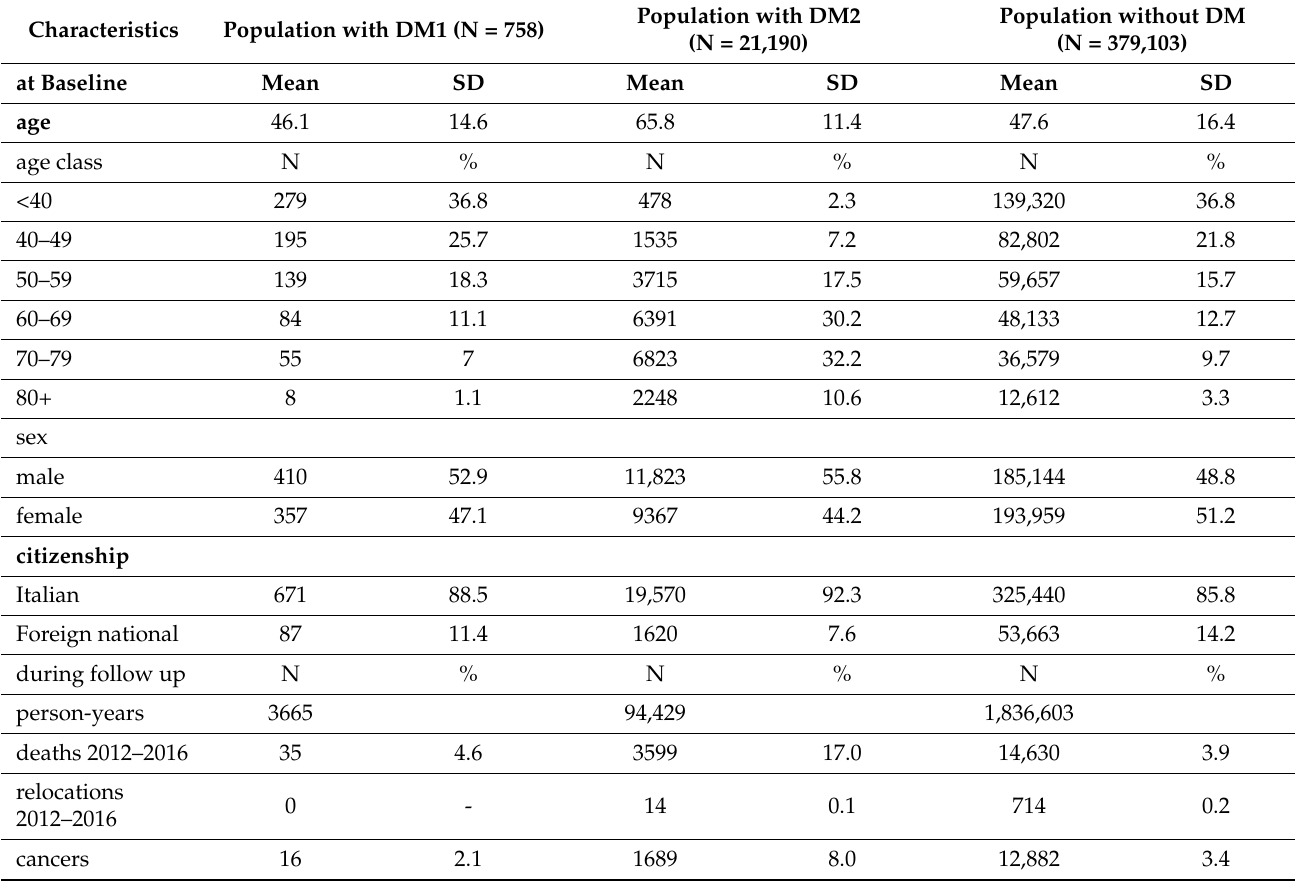
Table 1. Baseline characteristics of the cohort according to the presence of type 1 and type 2 diabetes (DM1; DM2) as of 31 December 2009 and still alive at 31 December 2011, outcomes and